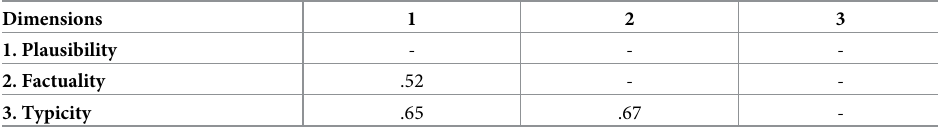
Table 2. Correlations between the three dimensions of perceived realism. Dimensions